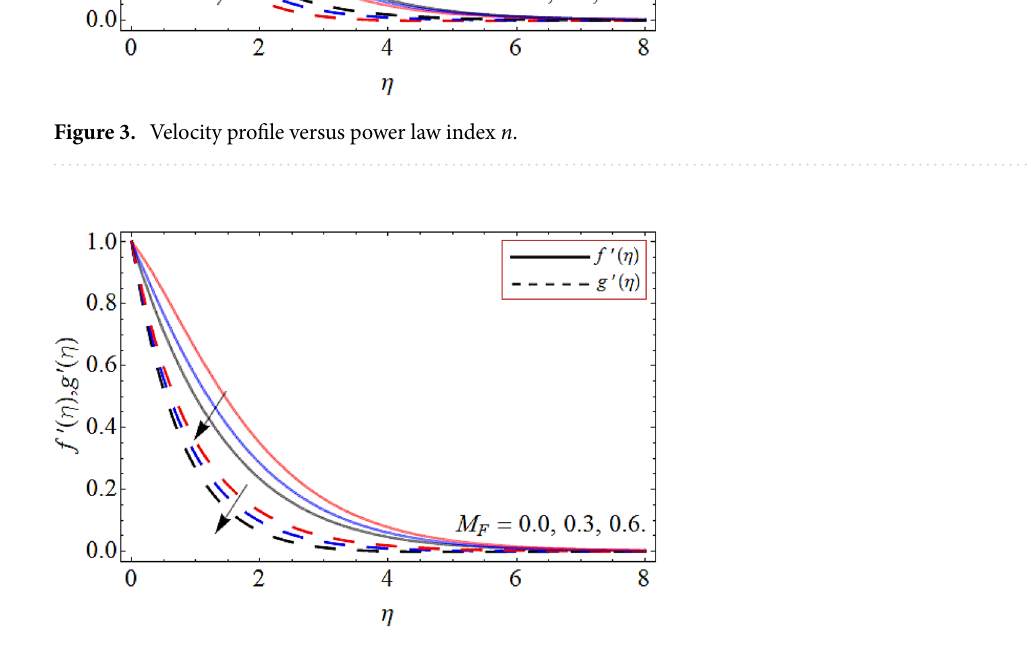
Figure 4. Velocity profile versus magnetic field constraint M F